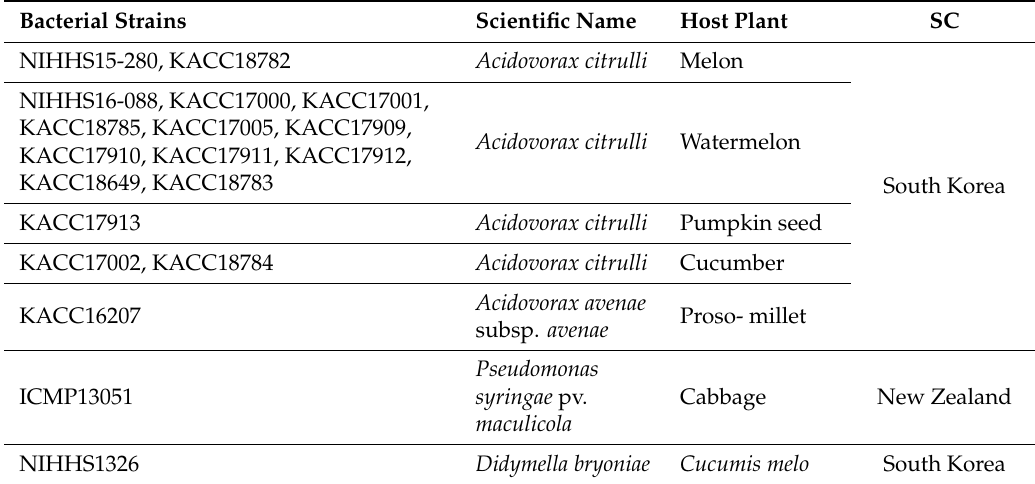
Table 1. Plant pathogenic bacterial strains of Acidovorax citrulli and other bacterial genera used in this study.